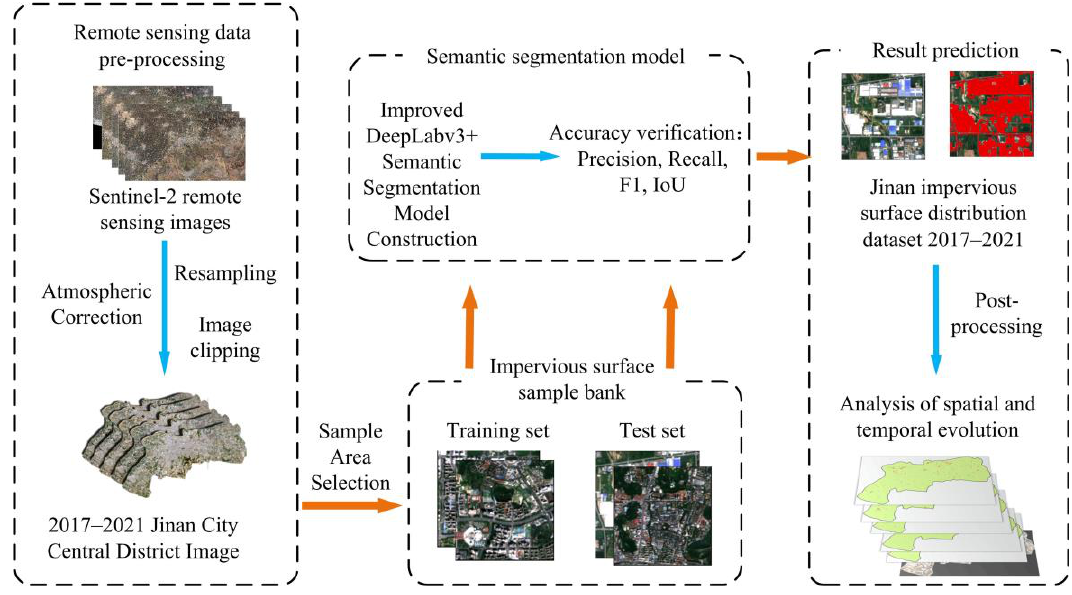
Figure 2. Methodology flowchart.